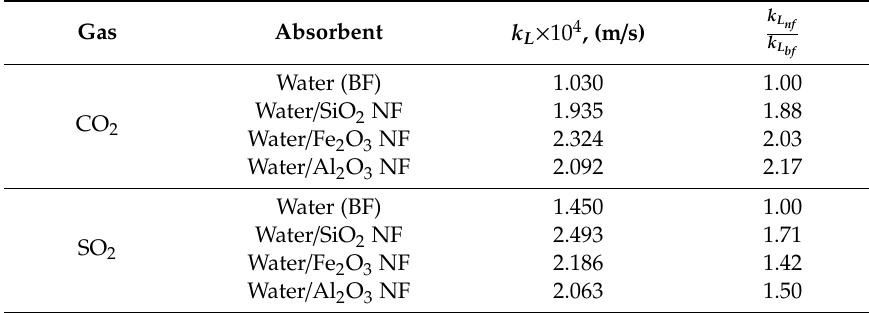
Table 3. Relative mass transfer coefficient for CO 2 and SO 2 in the base fluid (BF) and various nanofluids (NF).